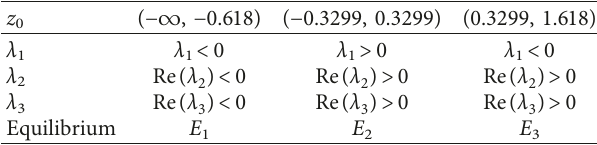
− z − 1 ) 2 < 4 b / a 0 0